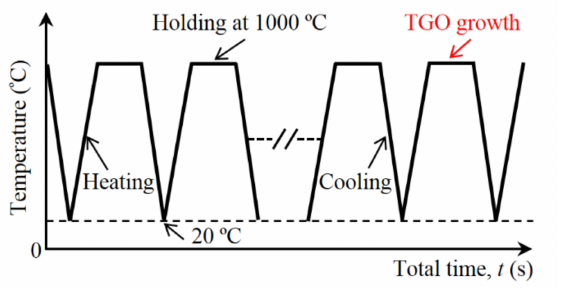
Figure 4. The cyclic thermal loading for all calculations (the number of thermal cycles is expressed by N